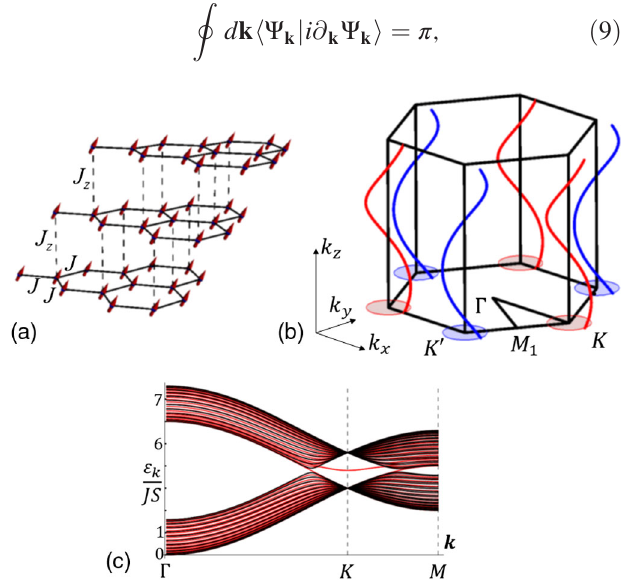
FIG. 4. (a) The 3D lattice structure of CrBr 3 . The honeycomb layers are composed of Cr atoms and are stacked in ABC order. (b) The band structure: Dirac nodal lines wind around the corners of the Brillouin zone. (c) Magnon energy spectrum for a 25-layer slab of a three-dimensional material. Results for open vs closed boundary conditions are shown with red and black